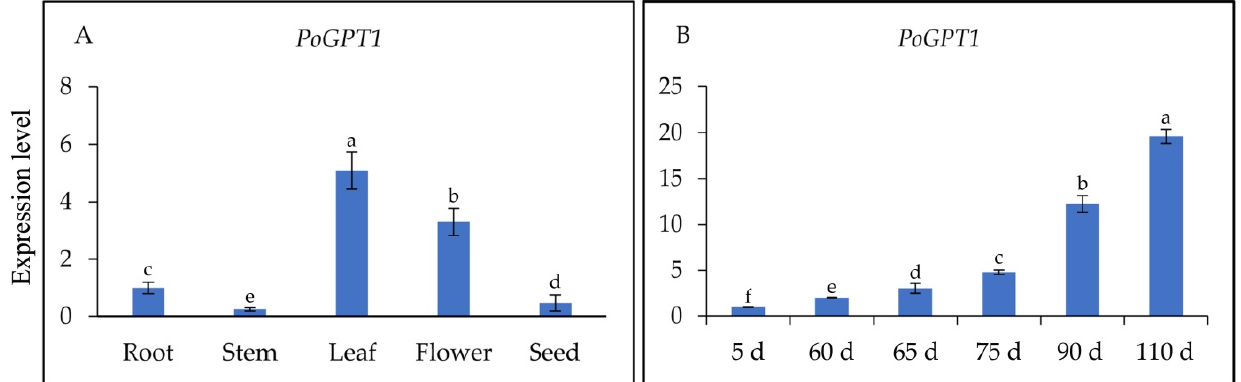
Figure 4. Spatiotemporal expression analysis of PoGPT1 in tree peony (( A ), Expression levels in different tissues of tree peony; ( B ), Expression levels at different stages of tree peony zygotic embryo development). Vertical bars indicate standard error ( n = 3). Different letters indicate significant differences using the Duncan’s Multiple Range Test ( p ≤ 0.05).